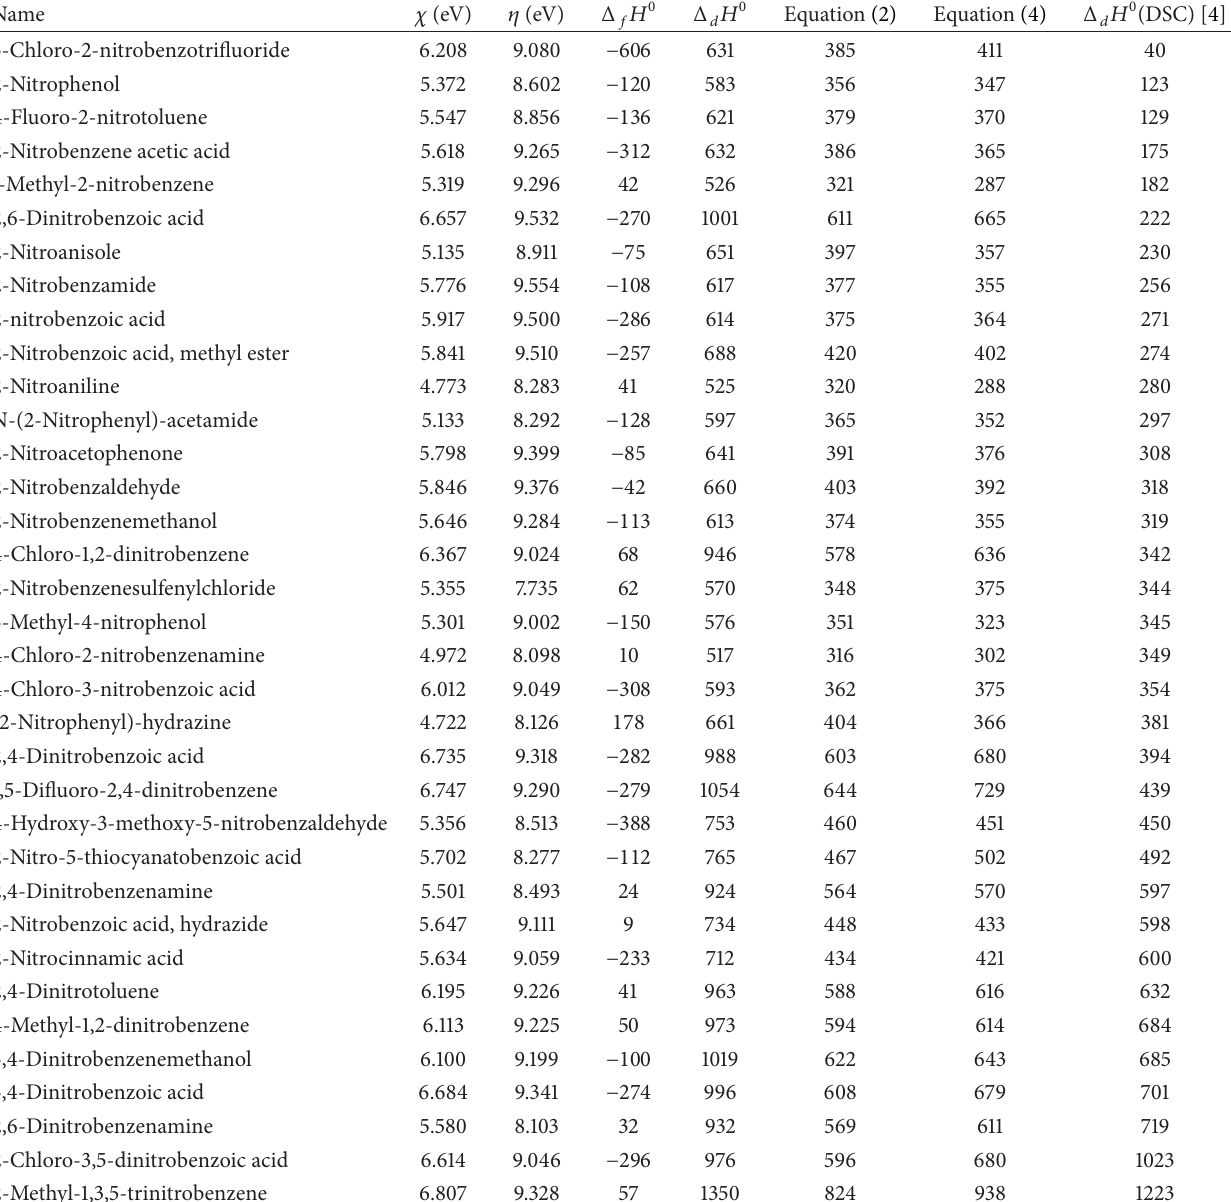
Table 4: Same data as in Table 2 for the 35 ortho compounds studied in pin-hole sample